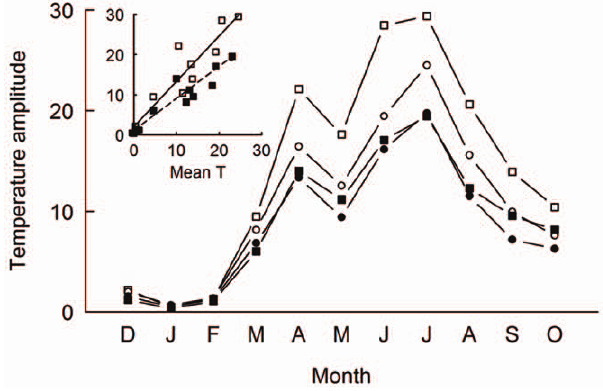
Figure 1. Average monthly temperature amplitude at soil surface. Temperature amplitude in large (0.1 m 2 , squares) and small plots (0.01 m 2 , circles) without (controls, open symbols) and with a litter cover of initially 400 g m 2 2 (filled symbols) throughout the first eleven months of the experiment. Inset figure shows the correlation between monthly temperature amplitude (y-axis) and monthly mean tempera- ture (x-axis) of large plots with and without litter. The dashed and the continuous line show linear regressions for large plots with litter and large control plots, respectively; t-test of slopes: t=2.183, df=18, P=0.0425.